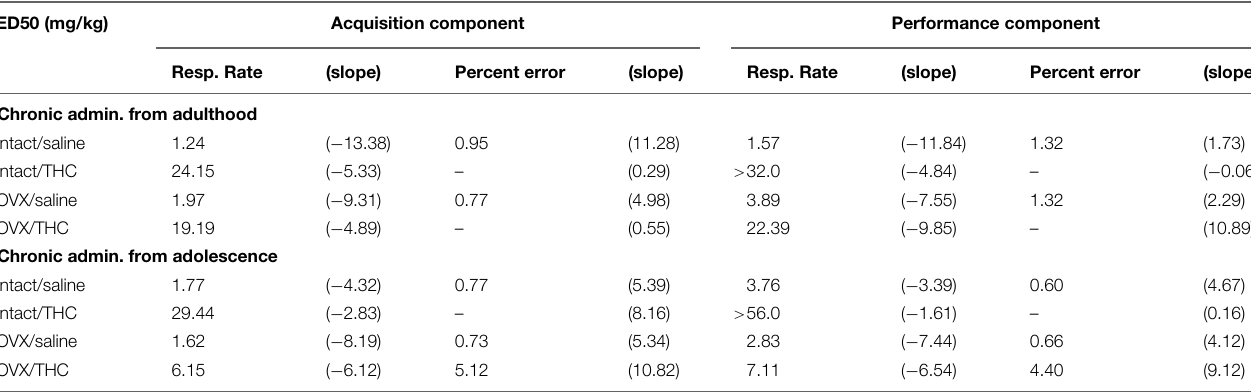
TABLE 2 | Effective (cid:2) 9 -THC dose (i.e., ED50s) for decreasing response rate by 50% and increasing the percentage of errors by 50% in female rats chronically administered saline or (cid:2) 9 -THC from early adulthood or adolescence, as calculated from a linear regression. ED50